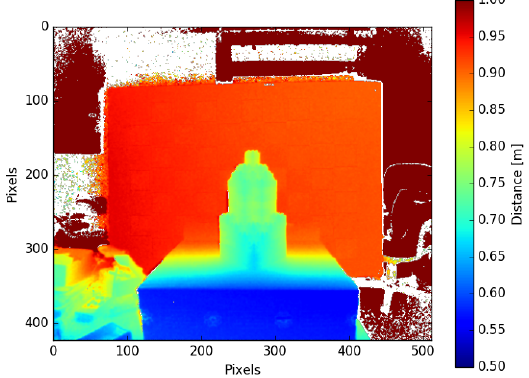
Figure 1: Depth map acquired by the Kinect v2 range